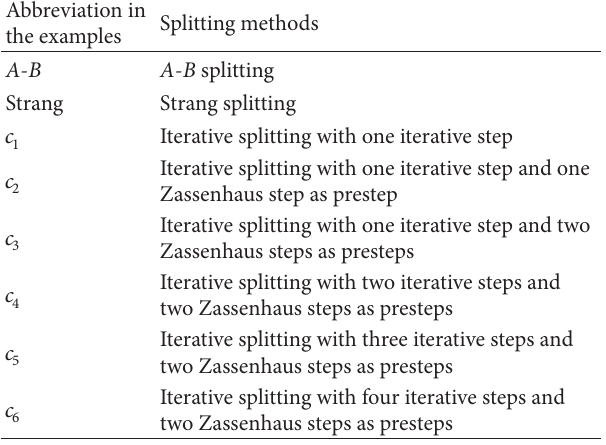
Table 1: Applied splitting